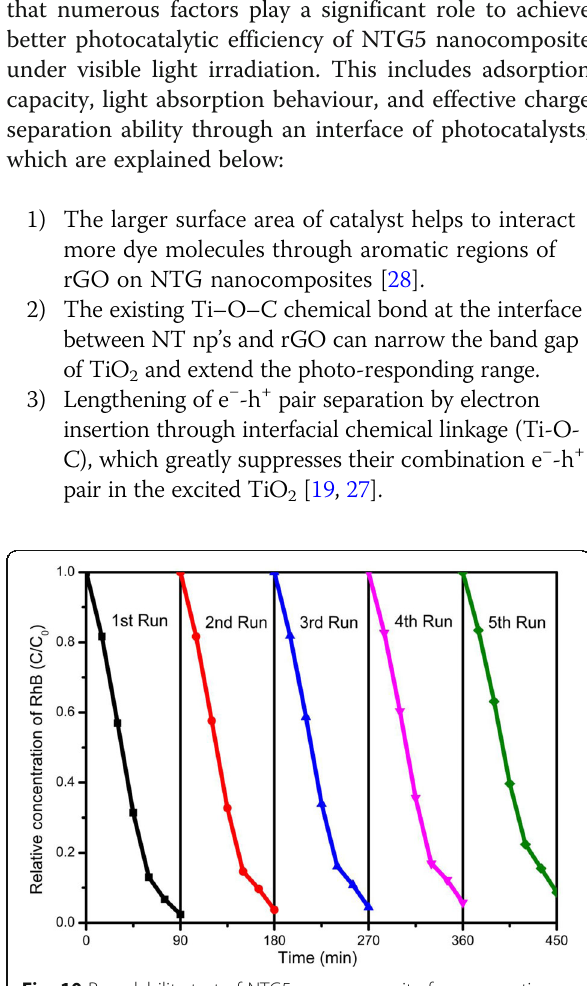
Fig. 11 Schematic representation for degradation of RhB dye on Nb doped TiO 2 /rGO